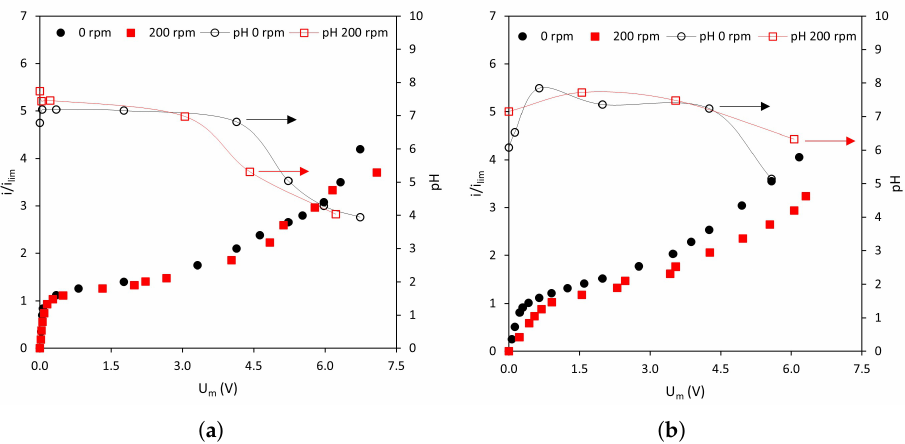
Figure 5. Current–voltage curves obtained at 0 and 200 rpm and pH evolution of the solution in the diluted ED compartment vs. U m . ( a ) AMV-N, ( b )